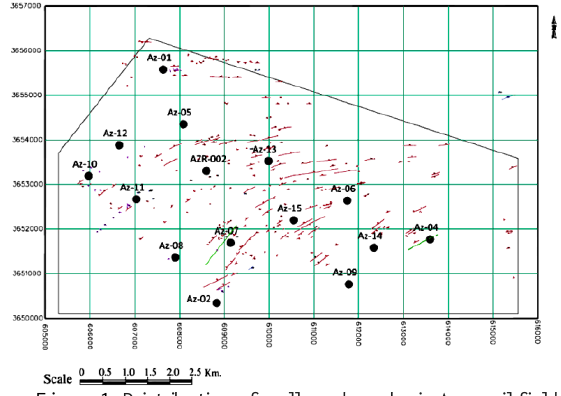
Figure 1. Distribution of wells and cracks in Azar oil field The length of this tank is 36 km in the northeast, southwest direction, 13.5 km of which is located in Iran, and it extends along a width of 30 km. Some cracks are shown in Figure 2.